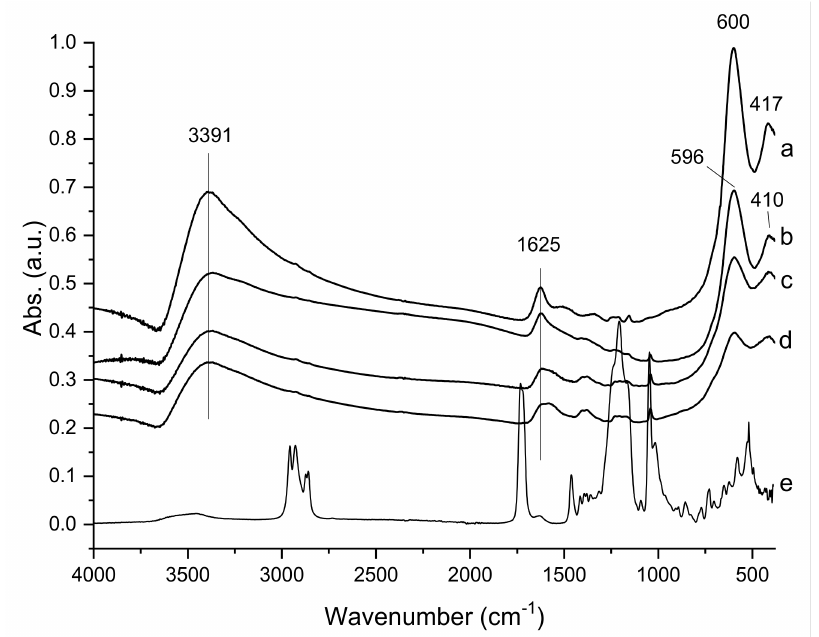
Figure 3. FTIR spectra of (a) CoFe 2 O 4 —0; (b) CoFe 2 O 4 —0.1; (c) CoFe 2 O 4 —0.25; (d) CoFe 2 O 4 —0.5; (e)